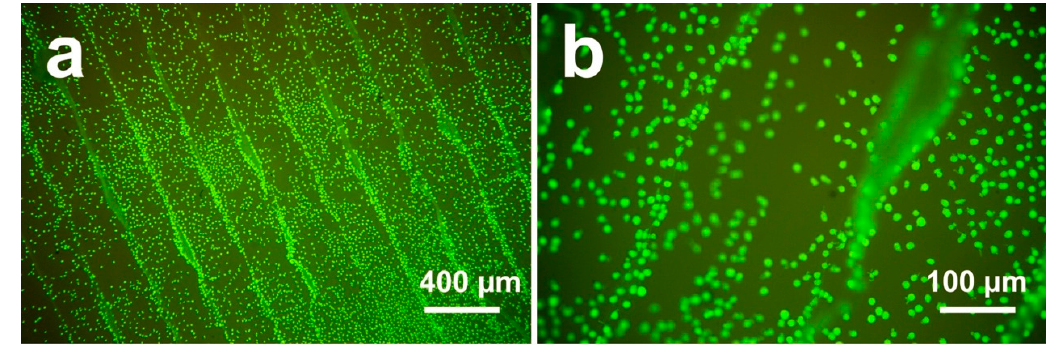
Figure 8. LIVE/DEAD staining of cells attached to FFF 3D printed PEEK sample surfaces after Figure 8. LIVE / DEAD staining of cells attached to FFF 3D printed PEEK sample surfaces after culturing culturing for 24 h: ( a ) 25× magnification; ( b ) 100× magnification [10]. for 24 h: ( a ) 25 × magnification; ( b ) 100 × magnification